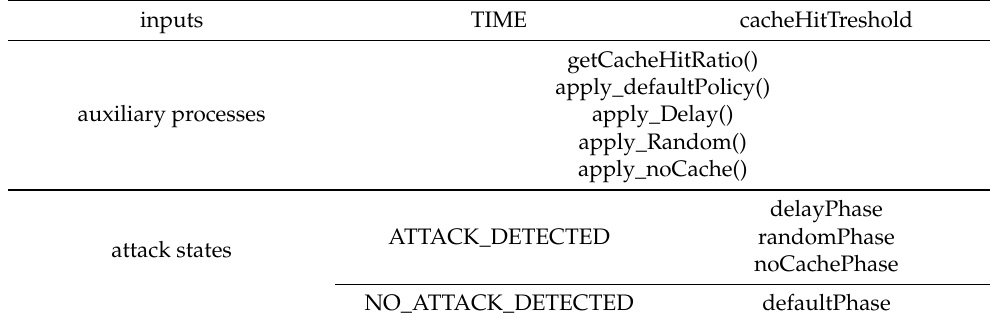
Table 1. Parameters of DaD